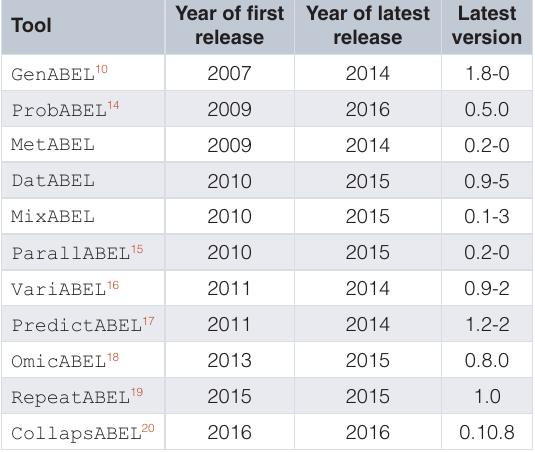
Table 1. The tools included in the GenABEL suite. Currently, all tools are licensed under the GNU Public Licence